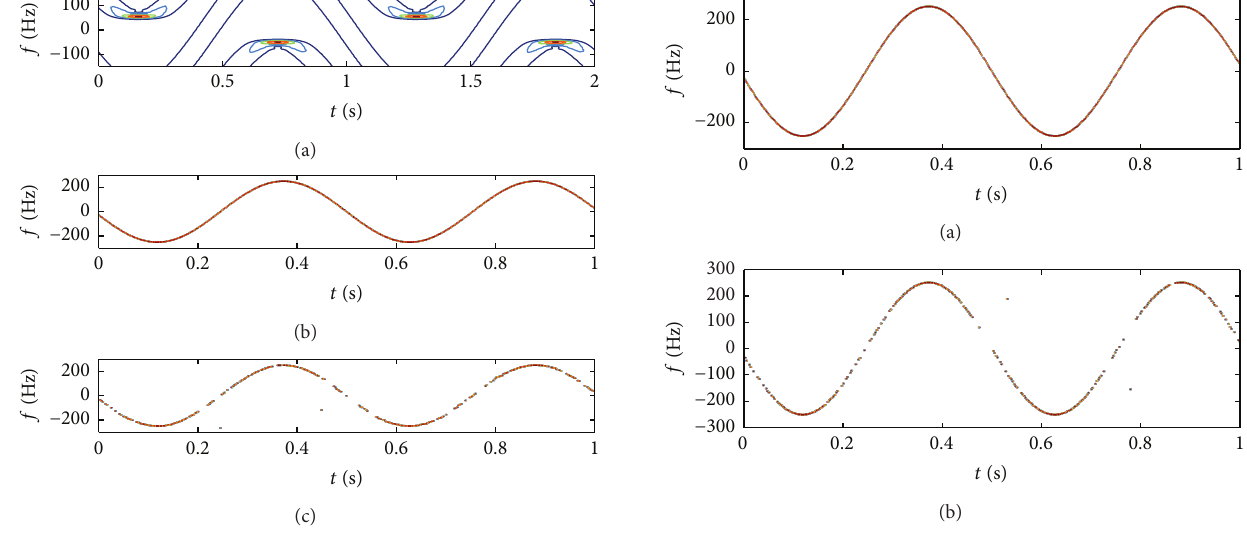
Figure 3: Micro-Doppler time-frequency spectrum: ambigu- ous time-frequency spectrum via STFT (a); unambiguous time- frequency spectrum of adding-perturbation fixed-PRF via CS (b); unambiguous time-frequency spectrum of adding-perturbation sparse-PRF via CS (c).